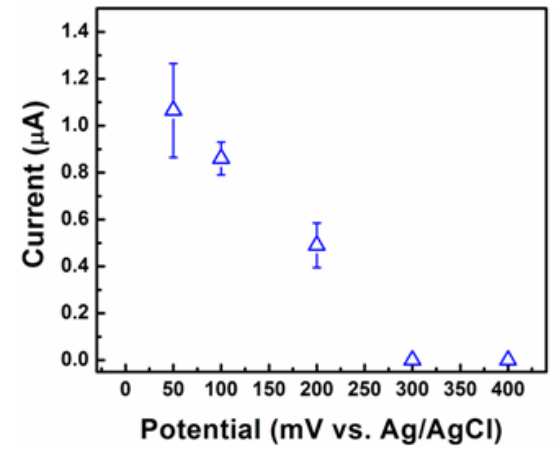
O to various potential 2 ] 3−/4− to 5 mM 6